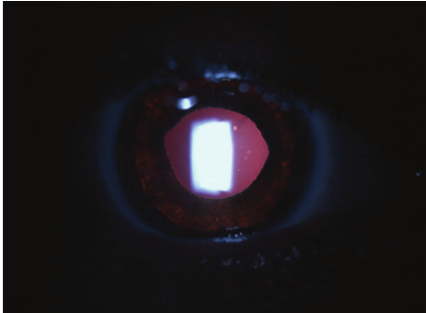
Figure 2: A transillumination defect is remarkable on the biomicro- scopic